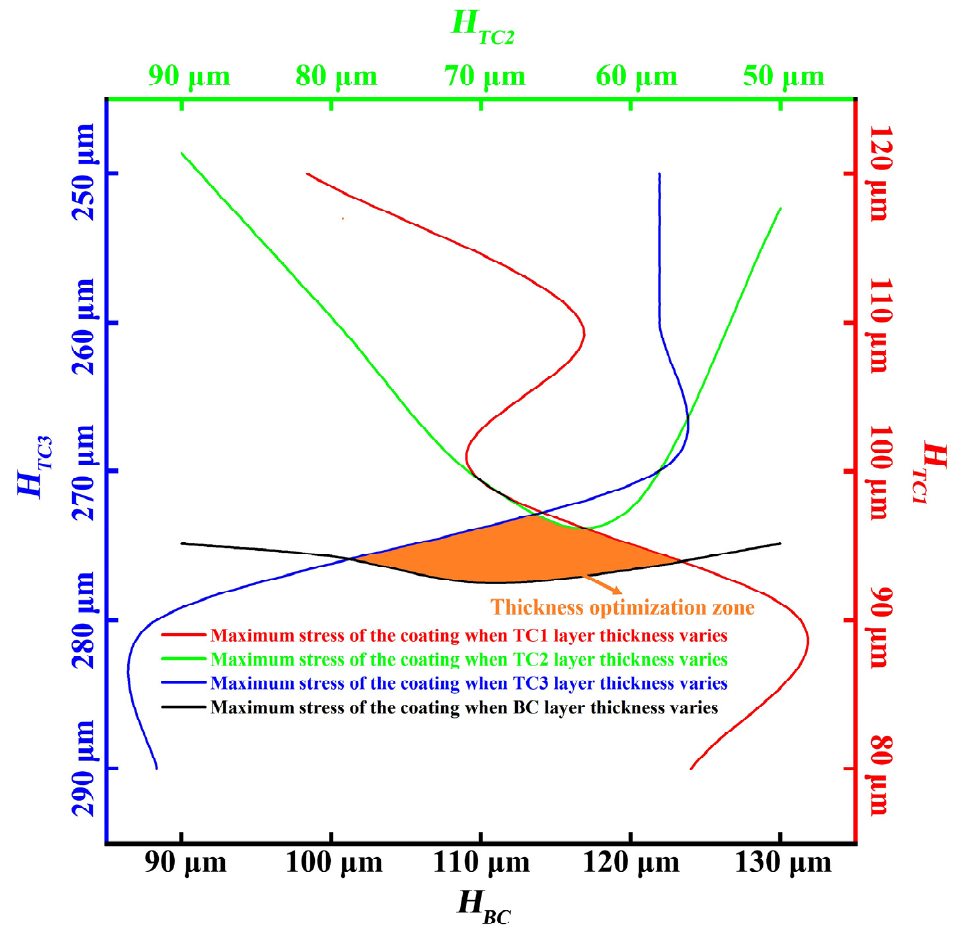
Figure 10. Schematic illustration for thickness design optimization.